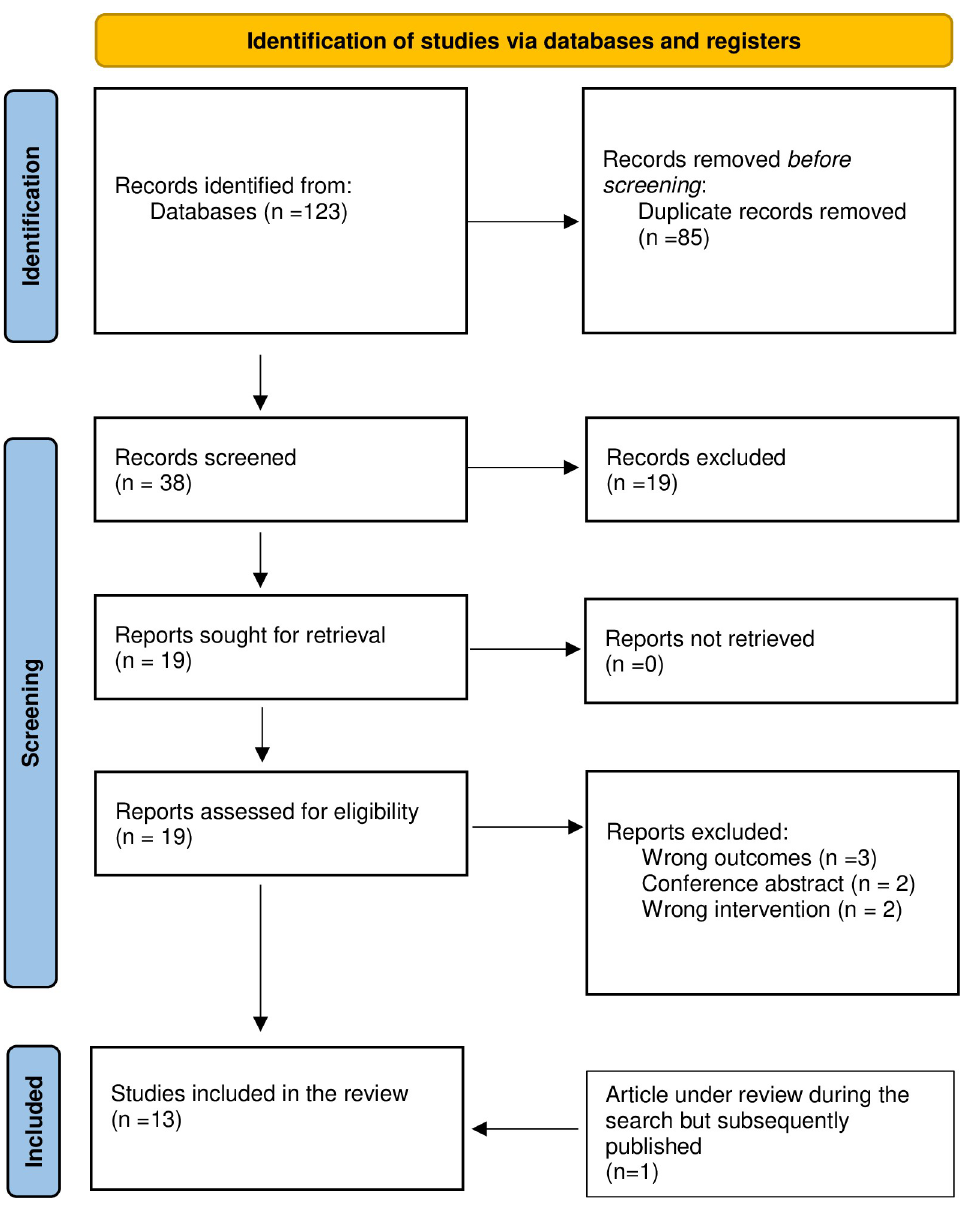
Fig 1. PRISMA 2020 flow